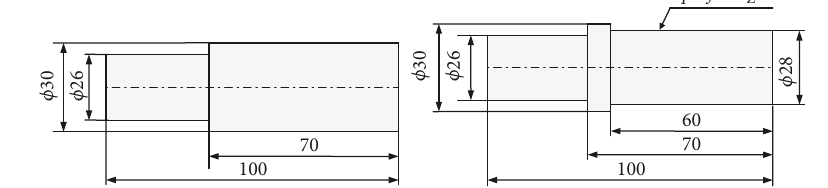
Figure 21: Workpiece configuration for machining (CT38).